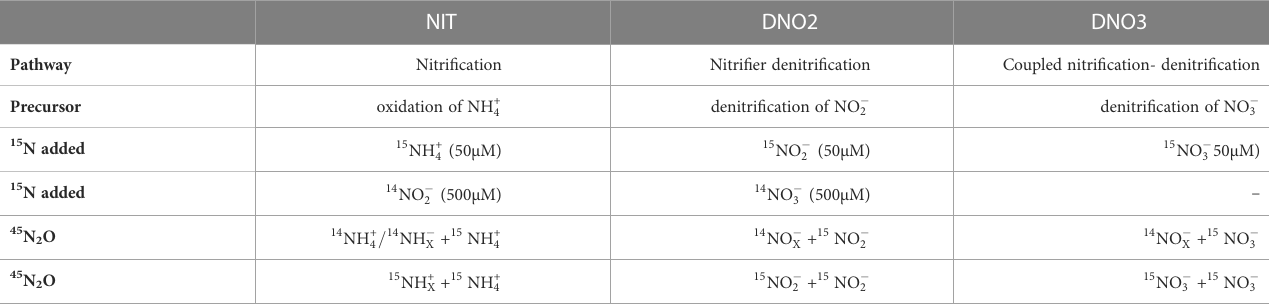
TABLE 2 Nitrogen tracer treatments NIT , DNO2 and DNO3 with the targeted N 2 O-producing pathway and precursor, the concentrations of 15 N and 14 N added to the tracer treatments and the possible combinations of 14 N and 15 N to form 45 N 2 O and 46 N 2 O, respectively.